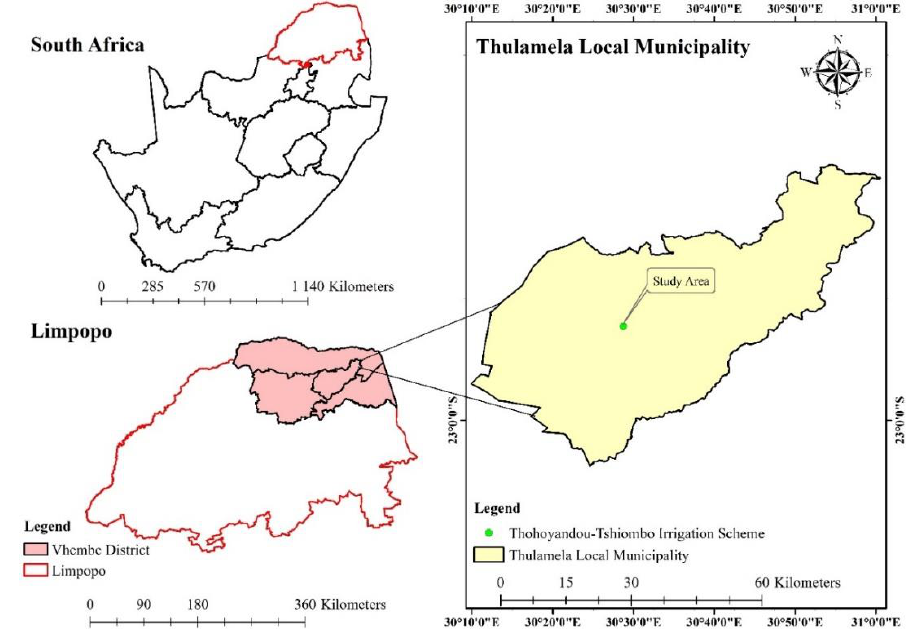
Figure 1. Study site, Limpopo Province (Source: Author).